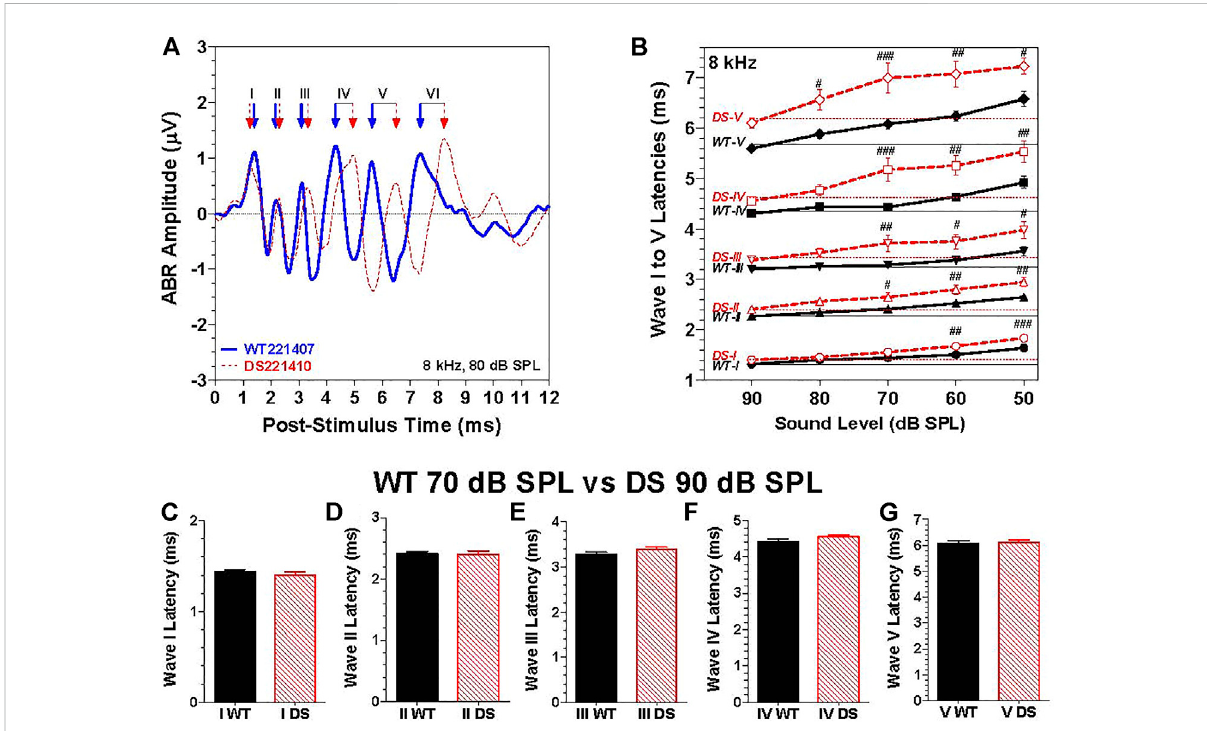
FIGURE 5 The latencies of waves I through V were longer in DS mice than WT mice at the same intensity. (A) Representative ABR waveforms from a WT (bluesolidline)andaDS(dashedredline)mouseevokedby8 kHztoneburstspresentedat80 dBSPL.PositivepeaksofABRwaveI,II,III,IV,V,andVI indicated for WT (blue arrows) and DS (red arrows) mice. (B) Mean (+/-SEM) latencies ofABR waves I,II, III, IVand V ofDS mice (red, dashed line) and WTmice (black,solidline)decreasedas intensity increased from50to 90 dBSPL(note: intensity axisreversed).Meanlatencies wereshorterfor DS than WT mice; the latency differences between DS and WT mice increased as intensity decreased. At each intensity, the latency increased from wave I to wave V. (C – G) . Mean (+SEM) wave I – V latencies of WT and DS mice are compared at 70 dB SPL versus 90 dB SPL respectively